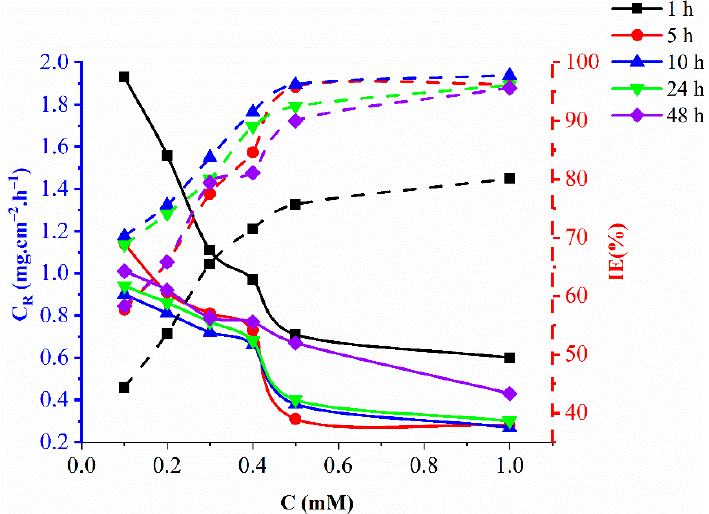
Figure 3. Effect of various concentrations of nicotinehydrazide derivative on the corrosion rate and inhibition efficiency of mild steel immersed in 1 M HCl for different times at 303 K.